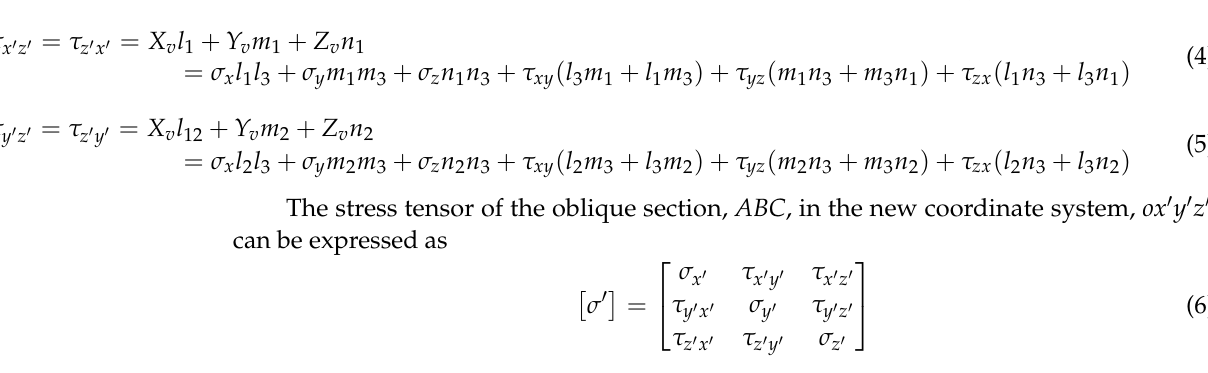
When the tetrahedral differential body OABC tends to be infinitely small, the x (cid:48) and y (cid:48) axes are in the oblique section, ABC. Therefore, the projection of X v , Y v , and Z v on the x (cid:48) and y (cid:48) axes indicates the shear stress of the oblique differential body section.